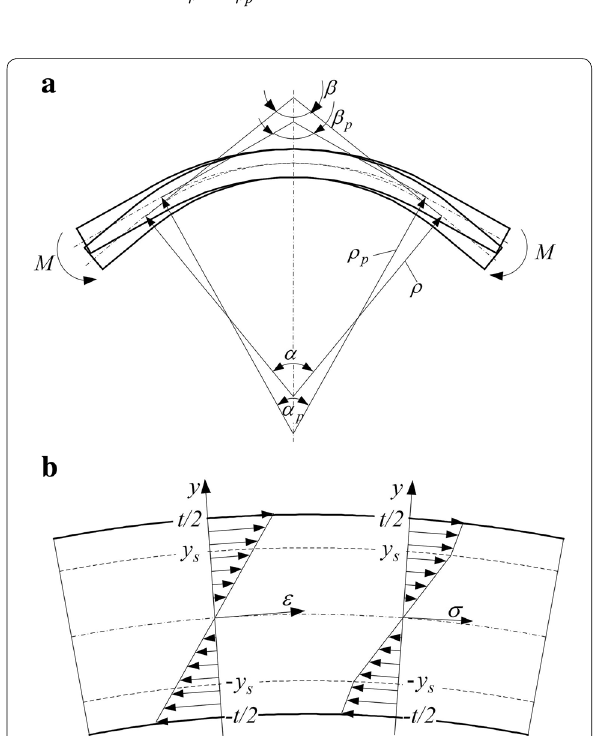
Figure 4 Analytical model of V-free